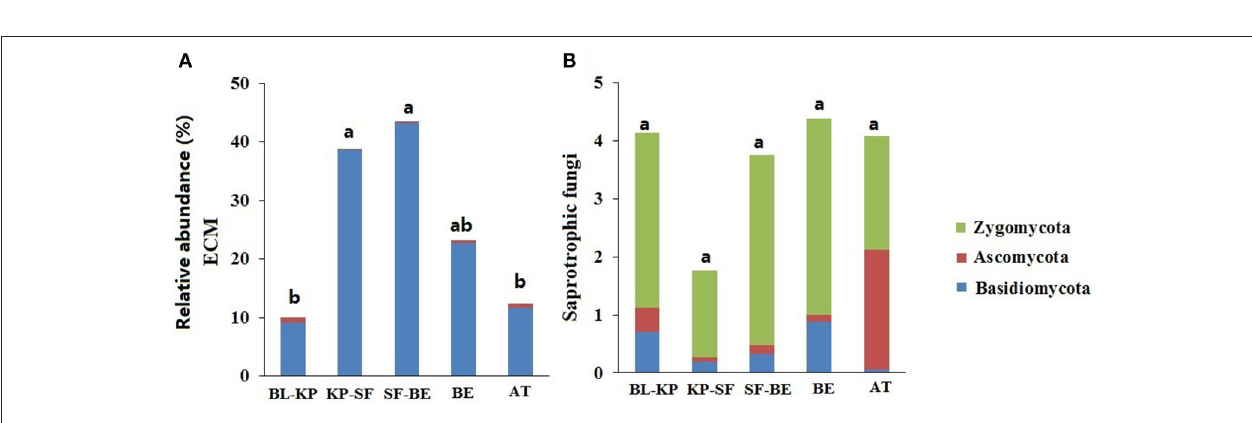
lower than the other vegetation types ( Figure 6B ), exhibiting a pattern consistent with that of Ascomycota ( Figure 3F